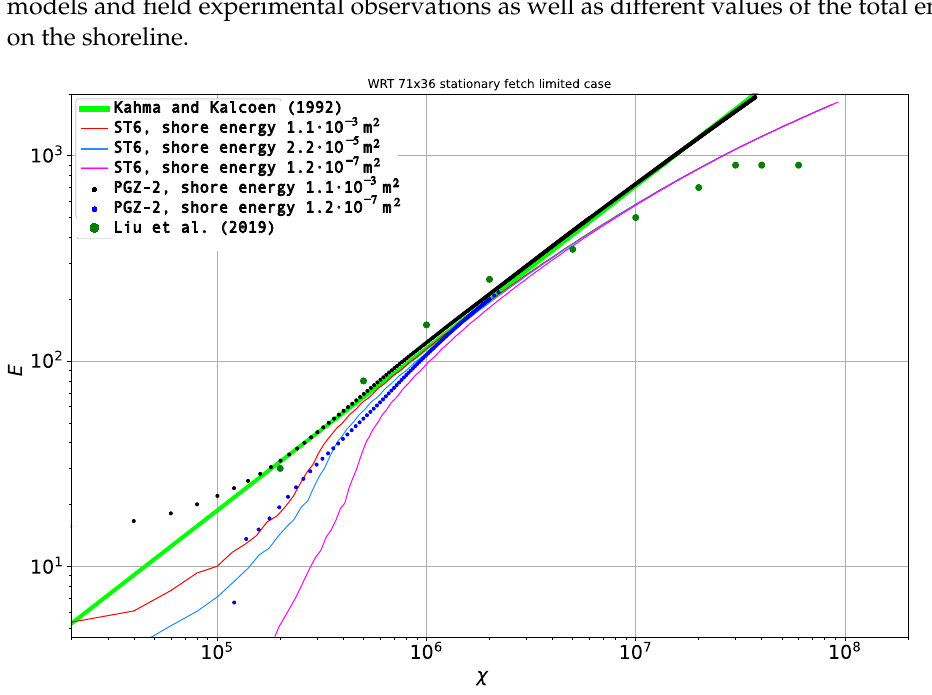
Figure 2. The dimensionless total wave energy as the function of the dimensionless fetch (logarithmic coordinates). The curve notations are on the chart. ST6 and PGZ-2 data calculated by the authors, Kahma and Kalcoen from [36], Liu et al from